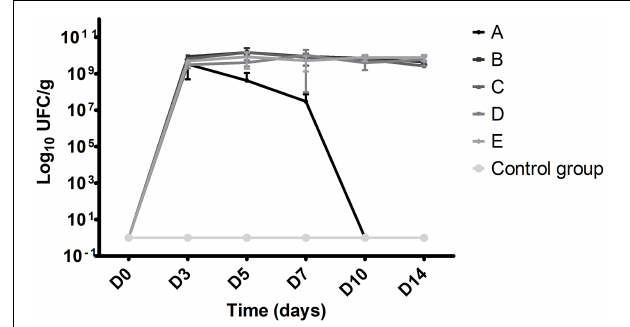
FIGURE 4 | VREF bacterial load in fecal pellets according to antibiotic regimen and time. Each point represents the mean value of cfu values per gram obtained from five mice. A Clindamycin SC + gentamicin DW, B ceftriaxone SC + cefoxitin DW, C ceftriaxone SC + DW, D ceftriaxone SC + amoxicillin DW + cefoxitin DW, and E ceftriaxone + amoxicillin SC and DW (SC, subcutaneous; DW, drinking